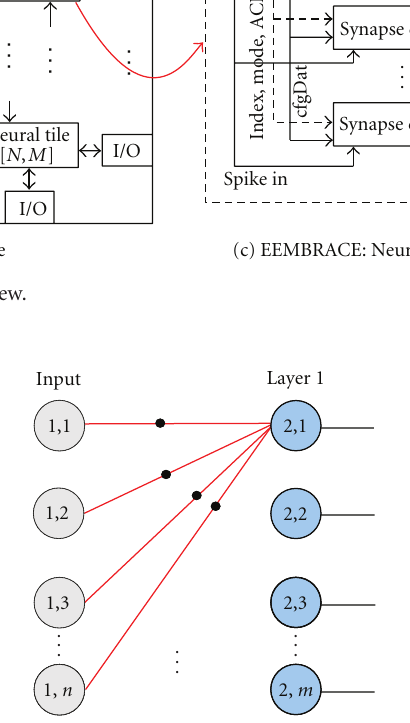
Figure 2: n x m network showing only the synapse inputs to neuron (2,1). Each of the m neurons in layer 1 has n synapse